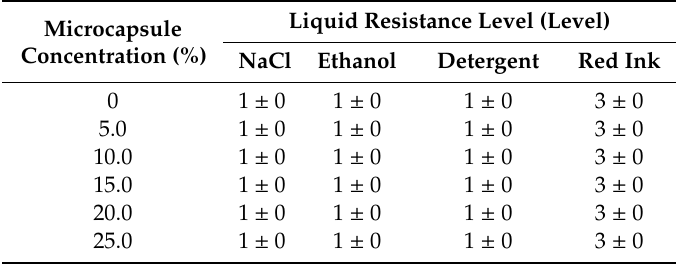
Table 8. E ff ect of the Concentration of Microcapsules with 0.58:1 Core–Wall Ratio on the Liquid Resistance Level of Waterborne Primer